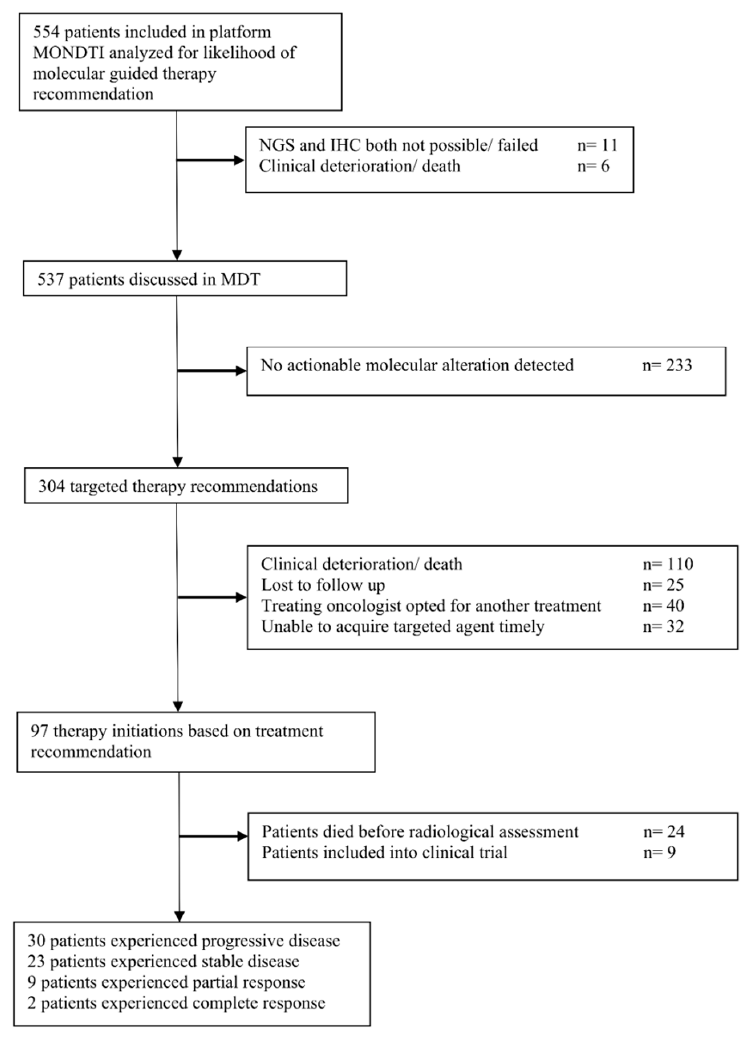
Figure 2. Flow of patients.